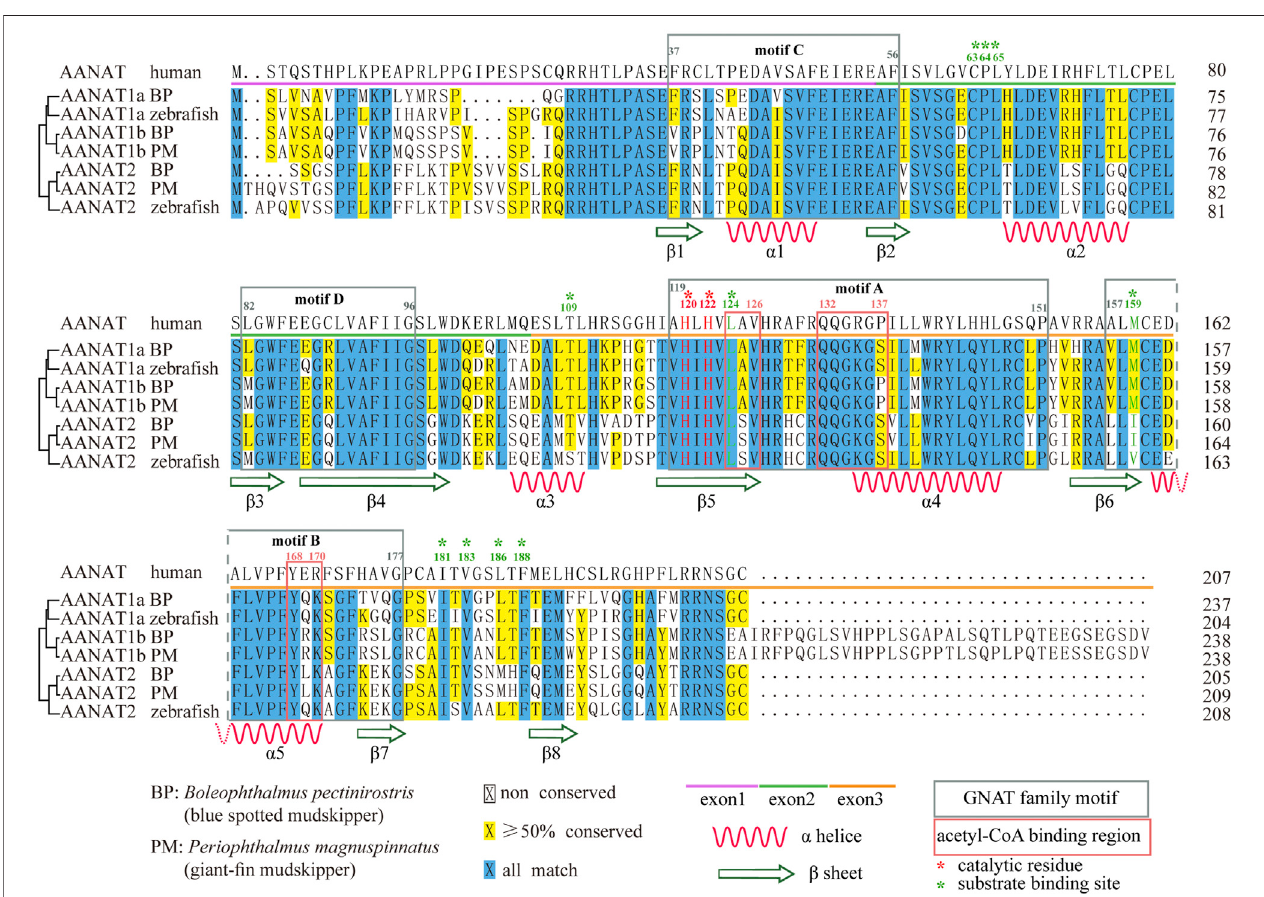
FIGURE3| SequencealignmentofAANATproteins.Conservedmotifsandsecondarystructuresofalphahelix( α )andbetastrand( β )areshown.Catalyticresidues (red)andsubstratebindingsites(green)aremarkedwithasterisks.BP( Boleophthalmuspectinirostris )andPM( Periophthalmusmagnuspinnatus )aretworepresentative amphibious mudskippers (You et al.,